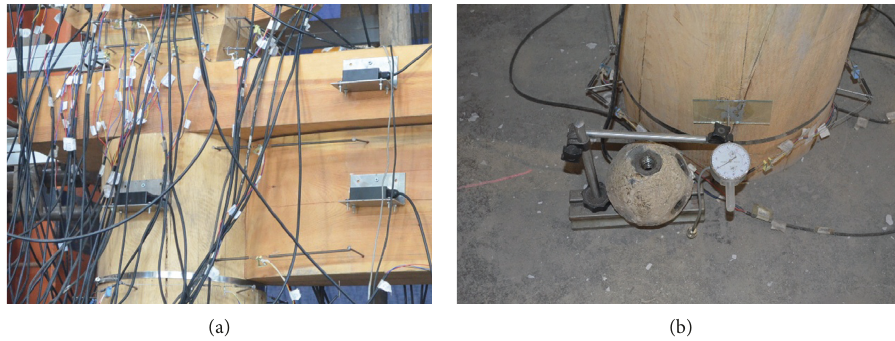
Figure 4: Measurement schemes. (a) Inclinometers; (b) dial indicator.